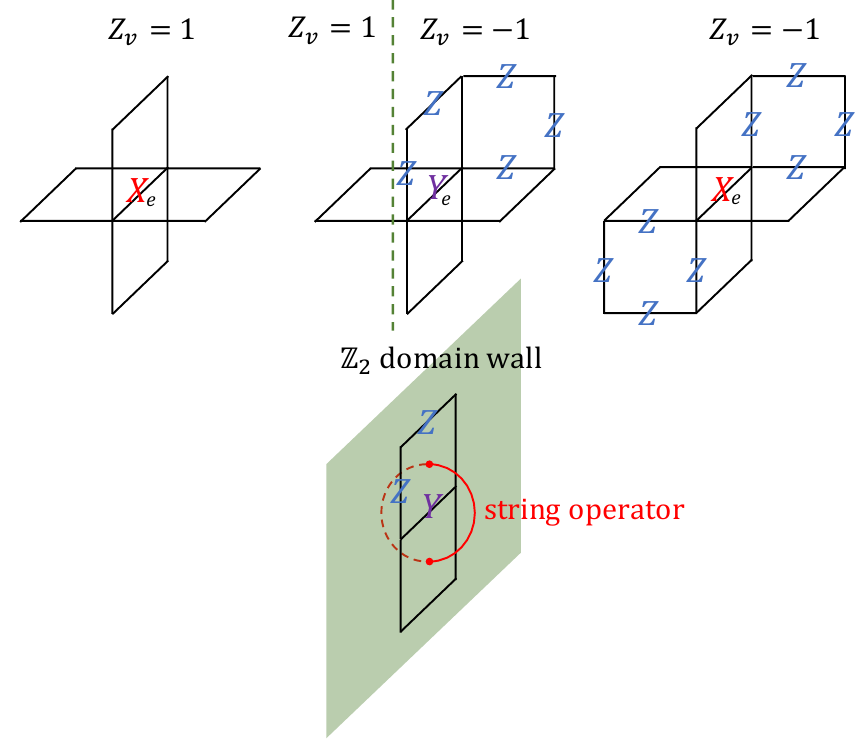
Figure 10: The intersection of the membrane and the domain wall is a fermion hop- ping